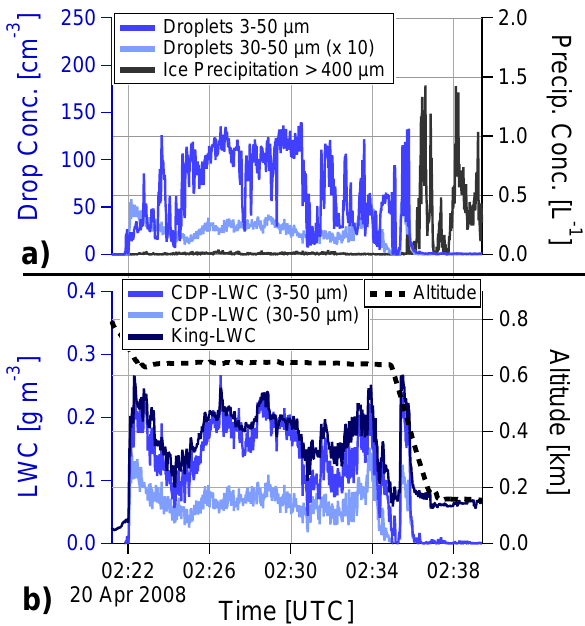
Fig. 5. (a) Timeseries of droplet and ice precipitation concentra- tions for clouds sampled during the clean case. Also shown are concentrations of large droplets (30–50µm) multiplied by a factor of 10 to aid visualization. (b) Timeseries of King-LWC and CDP- LWC. Although only a very small fraction of the observed droplets are > 30µm, these large drops often account for a major fraction of the observed LWC, as shown for this